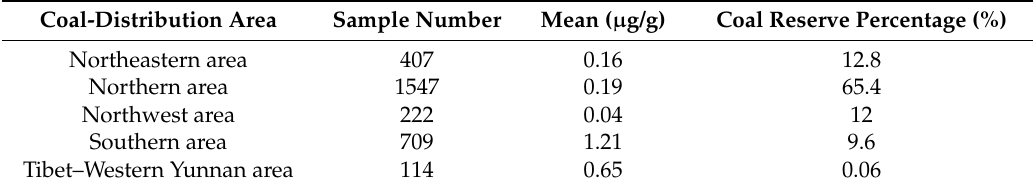
Table 6. The arithmetic average of cadmium in different coal-bearing